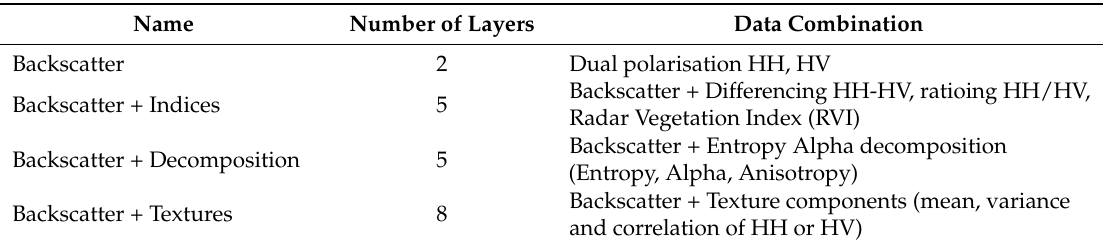
Table 1. Data combinations to assess the augmentation of dual polarisation SAR with synthetic layers for